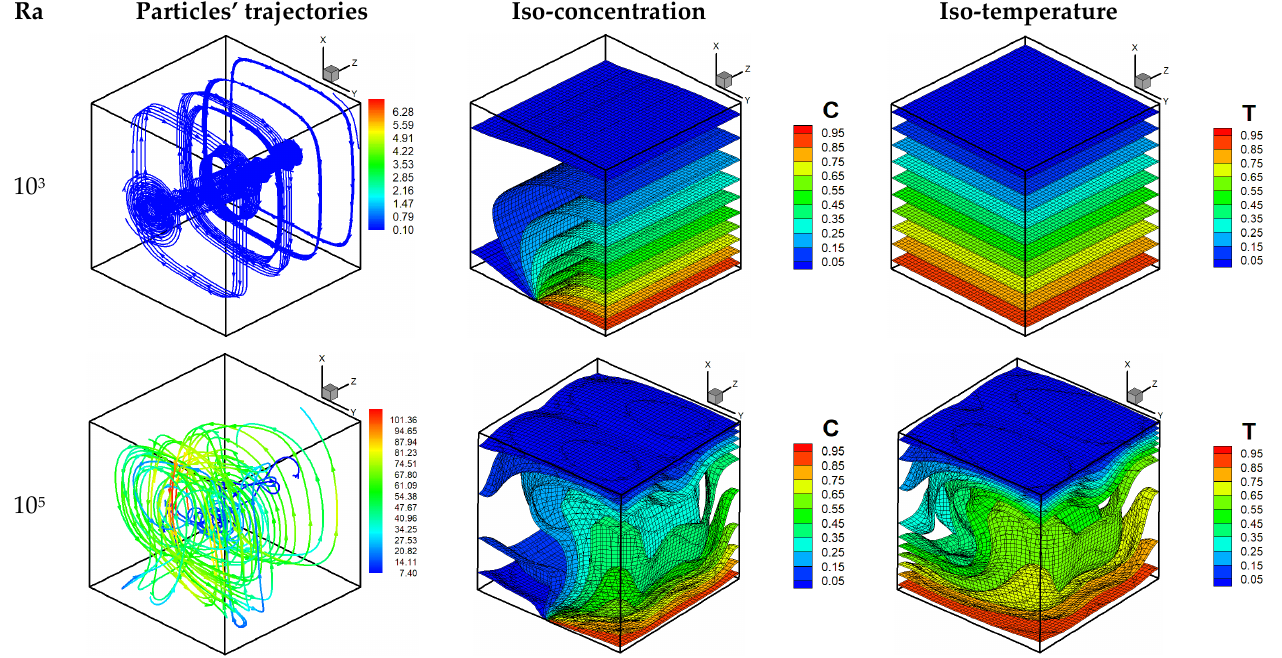
Figure 4. Particles’ trajectories, iso-concentration and iso-temperature in the building without a barrier for N = 0, Ra = 10 3 and 10 5.